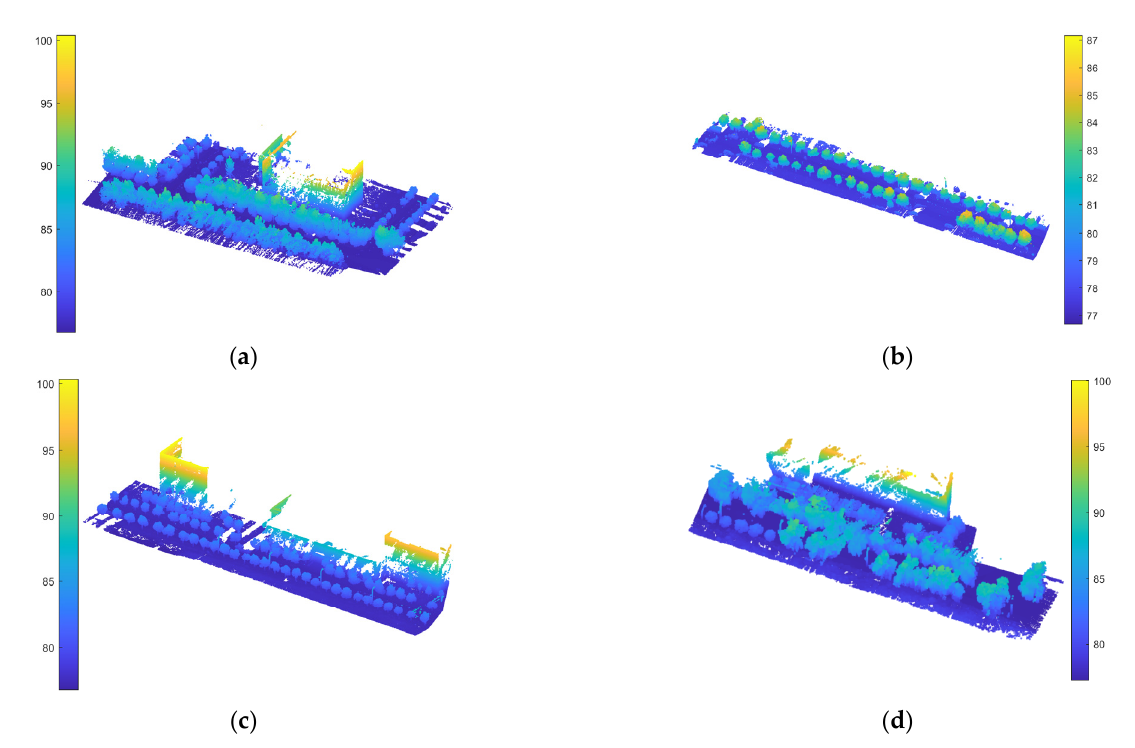
Figure 9. Four MLS plots with different characteristics: ( a ) Sample 1; ( b ) Sample 2; ( c ) Sample 3; ( d ) Sample 4. The points are colored based on elevation. Table 1. The characteristics of the four testing